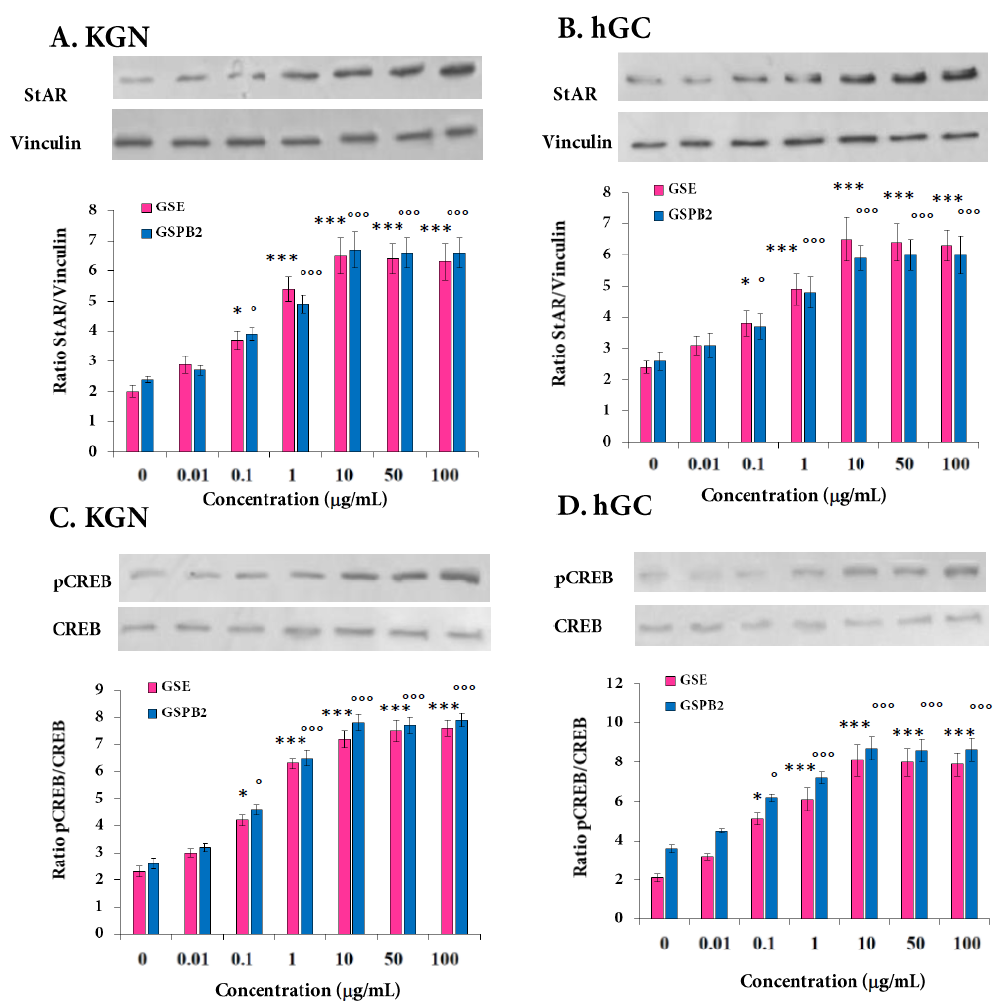
Figure 8. E ff ect of the GSE and GSPB2 treatments on the protein level of the cholesterol carrier StAR ( A , B ) and the phosphorylation level of transcription factor, CREB ( C , D ), in human granulosa cells. Protein extracts from KGN ( A , C ) and hGC ( B , D ) cells cultured for 48 h in the presence or absence of various concentrations of GSE and GSPB2 (0, 0.01, 0.1, 1, 10, 50, and 100 µ g / mL) were subjected to SDS-PAGE, as described in Materials and Methods. The membranes were incubated with antibodies raised against the StAR ( A , B ), and phospho-CREB ( C , D ). Equal protein loading was checked by reprobing the membrane with an anti-vinculin and total CREB antibodies, respectively. Results are representative of at least three independent experiments. Blots were quantified, and the StAR / Vinculin and phospho-CREB / CREB ratios are shown. Representative blots in response to di ff erent concentrations of GSE are shown. The results are expressed as means ± SEM. * and *** represent a significant e ff ect of GSE as compared to the control at p ≤ 0.05 and p ≤ 0.001, respectively. ◦ and ◦◦◦ represent a significant e ff ect of GSPB2 as compared to the control at p ≤ 0.05 and p ≤ 0.001,